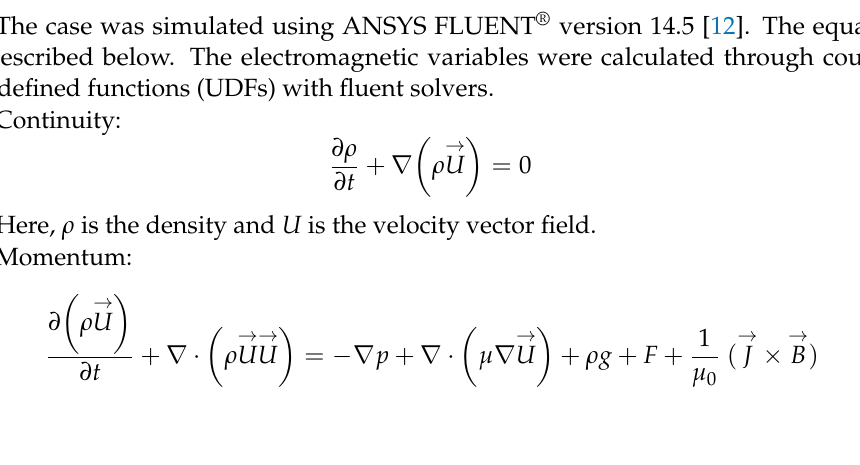
Figure 2. Geometry of the domain: R = 0.8, H = 1 m. The electrode length was 0.04 and the radius was 0.008; the arc gap ( G ) was 0.25, and the metal bath depth was initially 0.71 m.